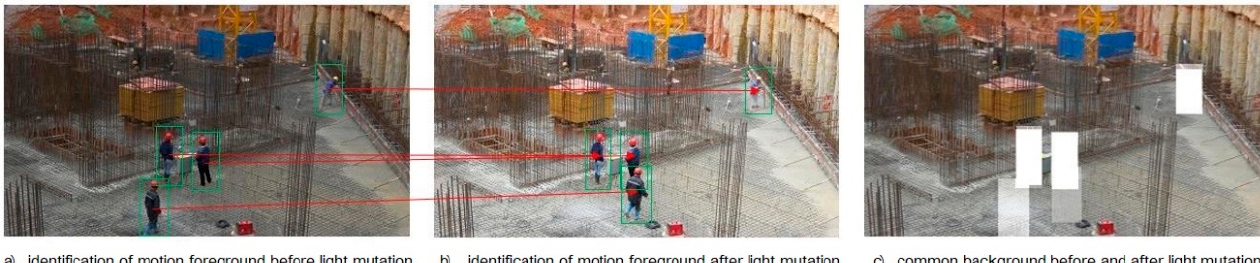
Figure 3. Common background of the first and second frames.